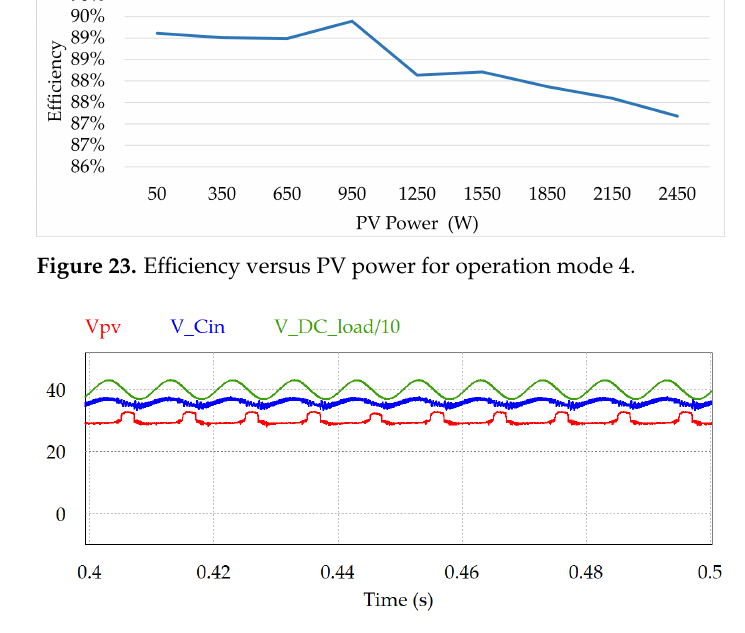
Figure 24. Simulation results of operation mode 4, PV voltage V PV —the voltage across input capacitor V C —DC bus voltage V DC _ bus / 10. in